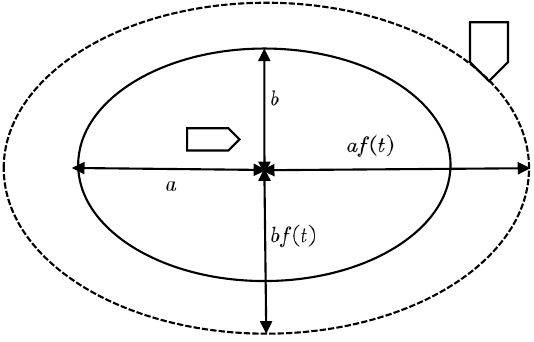
Figure 9. Schematic diagram of scaling factor of f . The dashed ellipse in Figure 9 shows that TS is just on the boundary of the changed ship domain after the coefficient f is scaled. For Equation (9), f min is denoted by DCPA TCPA denotes T min , D denotes f ( t ) , and CRI denotes. D s